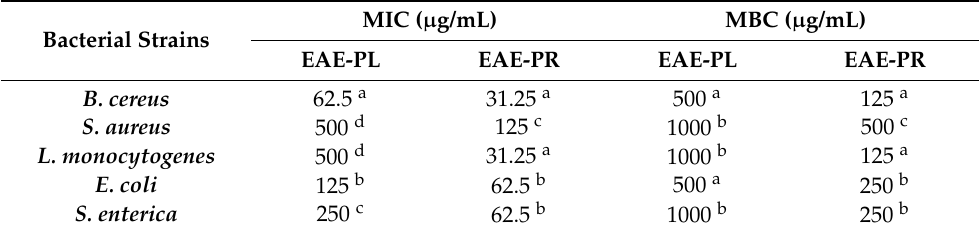
Table 4. Determination of the minimum inhibitory concentration (MIC) and minimum bacterici- dal concentration (MBC) of the EAE-PL and EAE-PR against Gram-positive and Gram-negative pathogens using a microtiter assay. The superscripts followed by the value represent significance ( p < 0.05) among samples. MIC ( µ g/mL) MBC ( µ g/mL) Bacterial Strains EAE-PL EAE-PR EAE-PL